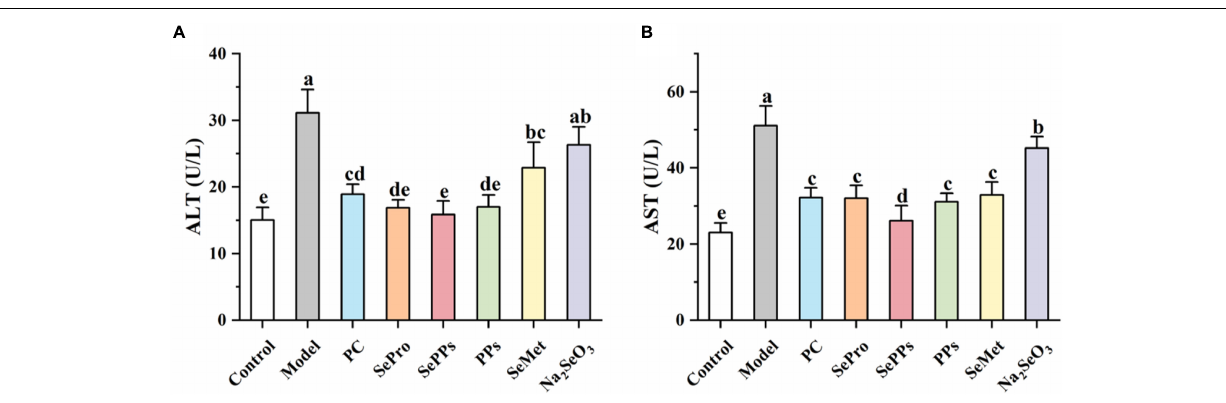
FIGURE 3 | Effects of different selenium supplements on ALT (A) and AST (B) in rat serum. Values are expressed as the mean ± SD, results marked with the same letters were not significantly different ( p >